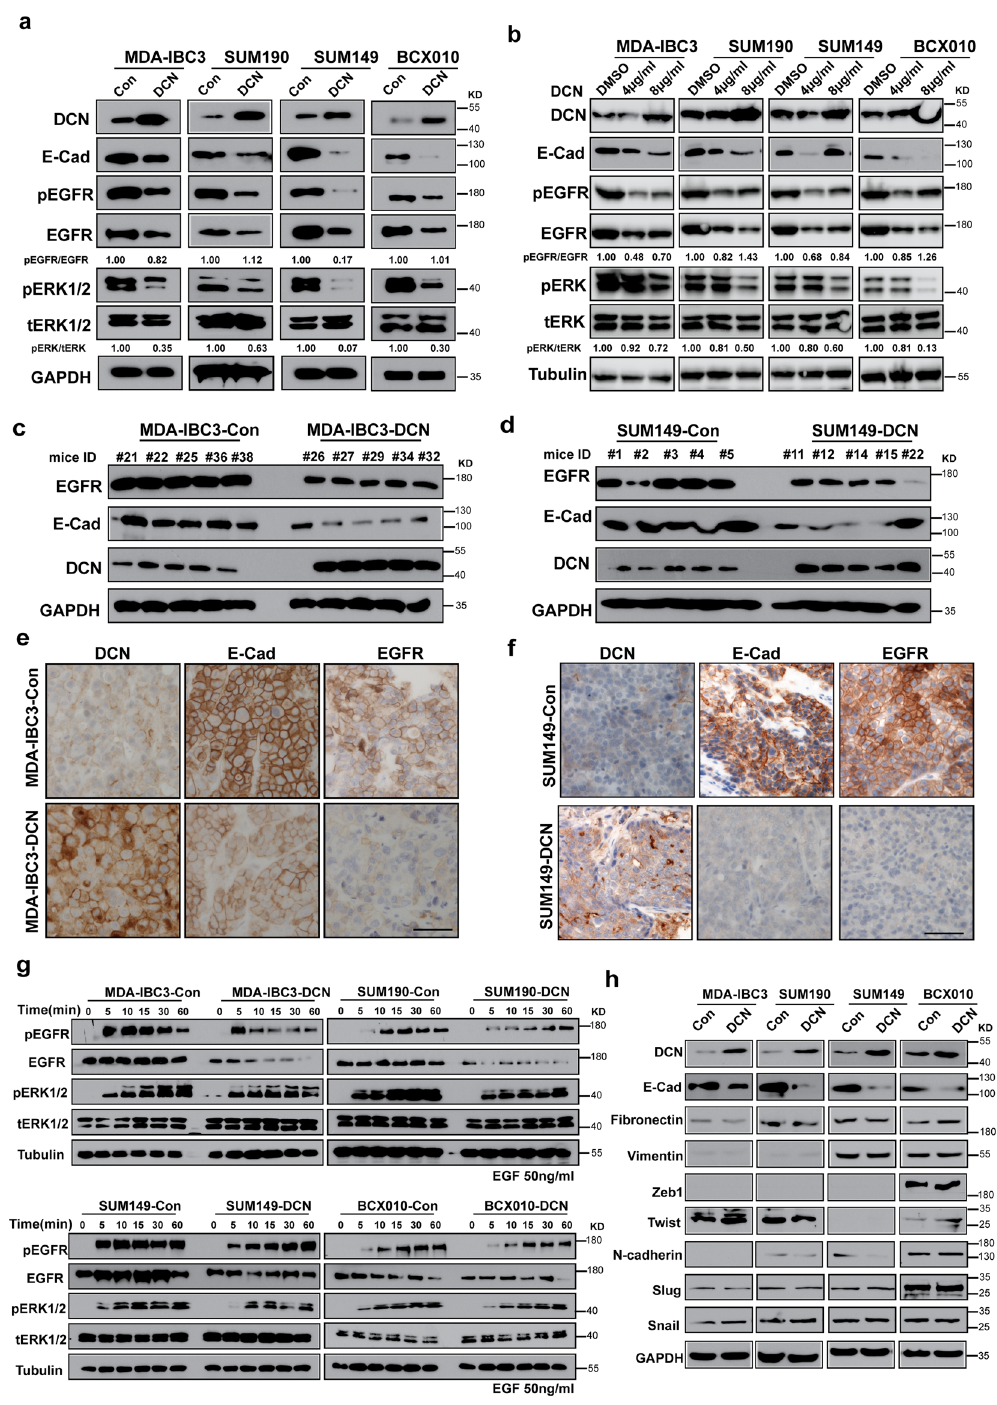
Fig. 3 DCN inhibits E-cadherin expression and EGFR pathway activation in IBC. a DCN suppresses E-cadherin expression and EGFR signaling in IBC cells. Expression levels of E-cadherin and EGFR are decreased in DCN-overexpressing MDA-IBC3, SUM190, SUM149, and BCX010 cells; also, the phosphorylation of EGFR (pEGFR) and ERK1/2 (pERK1/2) was suppressed in DCN-overexpressing IBC cell lines. Total ERK1/2 (tERK1/2) remains unchanged. GAPDH served as a loading control. b Treatment of IBC cells with DCN protein (4 or 8 μ g/mL) for 2 h suppresses E-cadherin expression and EGFR pathway activation. Tubulin served as a loading control. c and d Western blot validation of E-cadherin and EGFR downregulation in tumor samples obtained from mammary fatpad transplantation of control or DCN-overexpressing MDA-IBC3 ( c ) or SUM149 ( d ) cells. e and f Immunohistochemical staining validation of E-cadherin and EGFR downregulation in tumor samples obtained from mammary fatpad transplantation of control or DCN- overexpressing MDA-IBC3 ( e ) or SUM149 ( f ) cells. Scale bar: 100 μ m. g DCN inhibits EGFR signaling in IBC cells independently of EGF stimulation. DCN- overexpressing and control IBC cell lines were stimulated with 50 ng/mL EGF for the indicated number of hours, and total cell lysates were analyzed by western blotting. Both the total levels and the phosphorylation levels of EGFR and ERK1/2 were detected by western blotting. Tubulin served as a loading control. h DCN-mediated inhibition of E-cadherin does not affect expression of epithelial – mesenchymal transition markers. Cell lysates containing 40 μ g of total protein were analyzed by western blotting with anti-E-cadherin, fi bronectin, vimentin, and DCN antibodies. GAPDH served as a loading